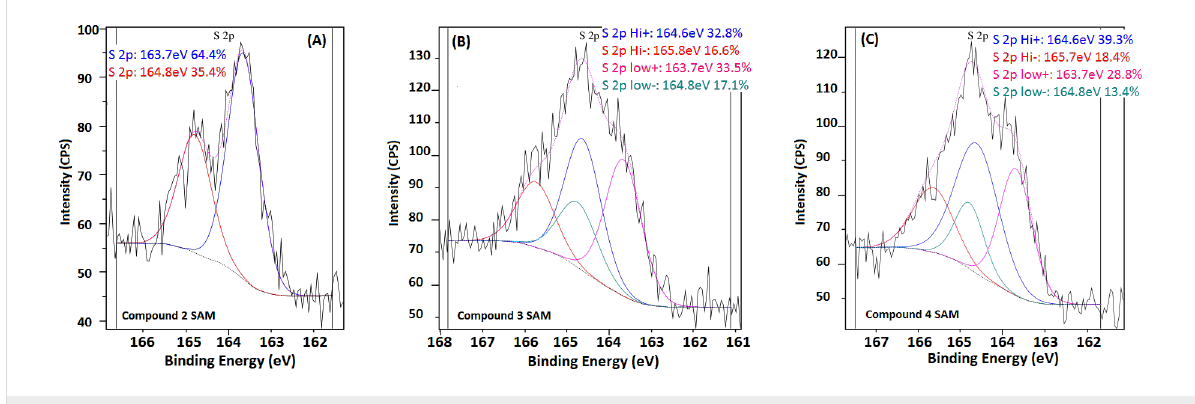
Figure 4: Representative sulfur XPS analyses of the SAMs of compounds 2 ( A ), 3 ( B ) and 4 ( C ).